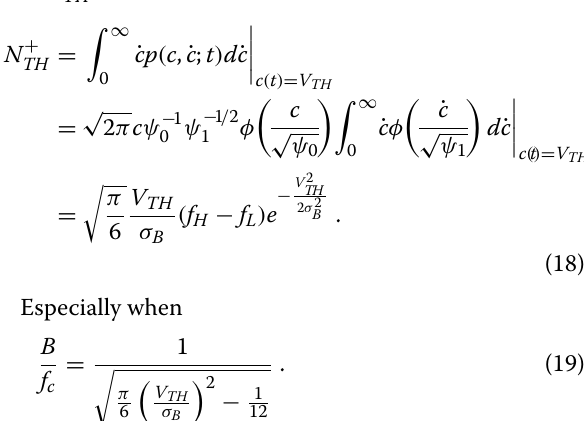
(cid:6) (cid:7) A 2 /σ 2 B